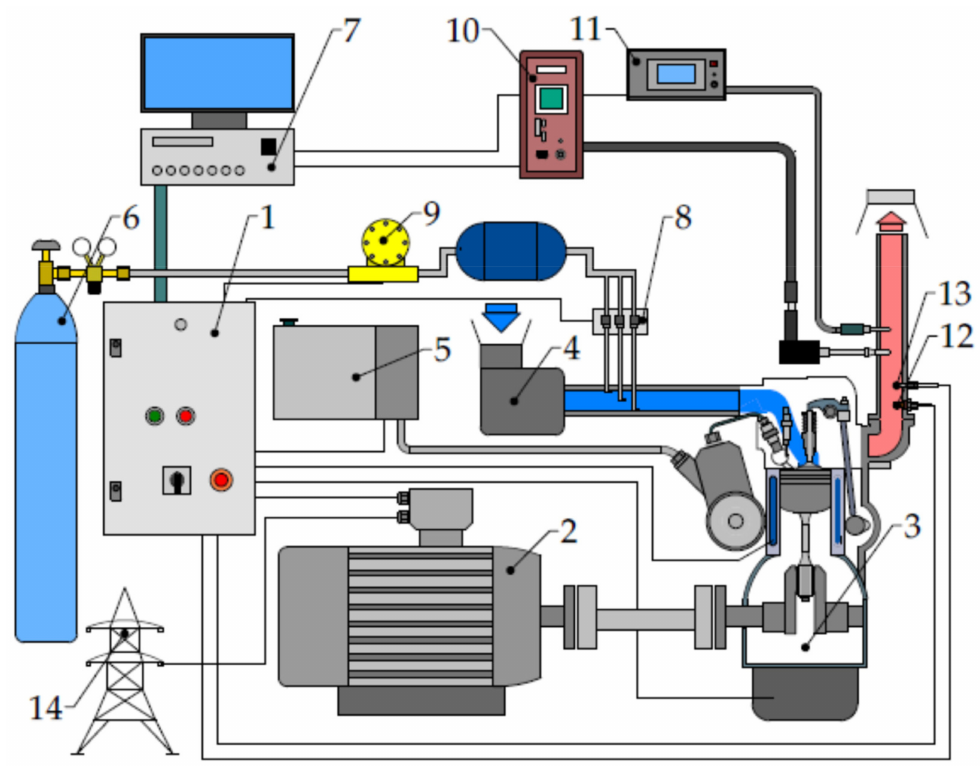
Figure 1. Research test stand and measuring system layout where: 1—Test stand management system; 2—Brake; 3—Engine; 4—Air filter; 5—Liquid fuel tank with fuel consumption measuring system; 6—Gaseous fuel tank with reducer; 7—Data acquisition system; 8—Gaseous fuel injector rail; 9—Gaseous fuel mass flow meter; 10—Gaseous exhaust components analyzer; 11—Particular matter analyzer; 12—Oxygen sensor; 13—Temperature sensor; 14. Grid.